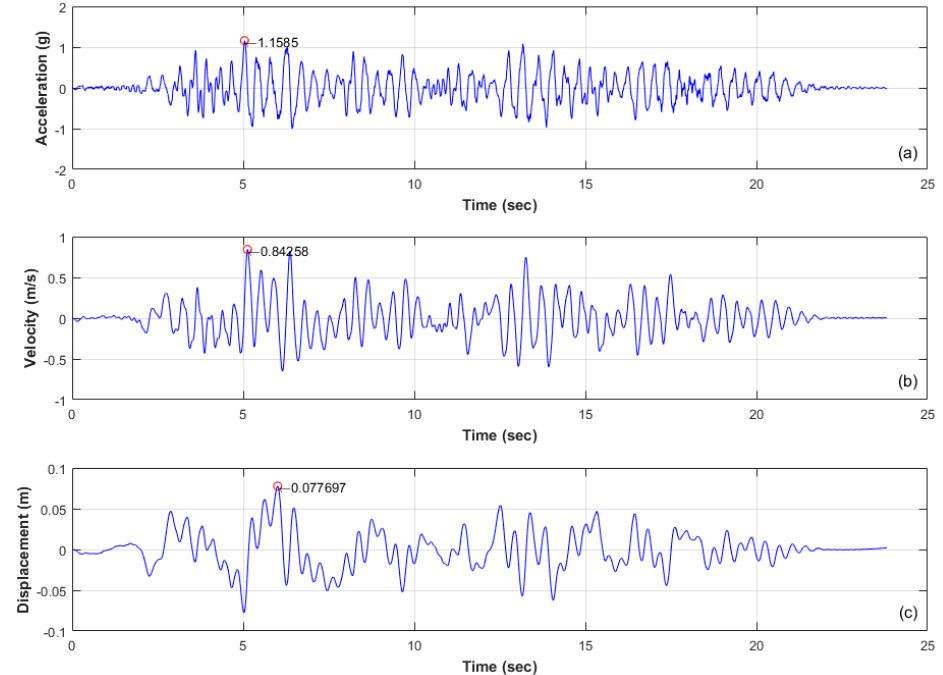
Figure 16. Analysis process for the 10th-story acceleration during the Superstition Hills earthquake using Method 2; ( a ) acceleration; ( b ) velocity; ( c ) displacement.